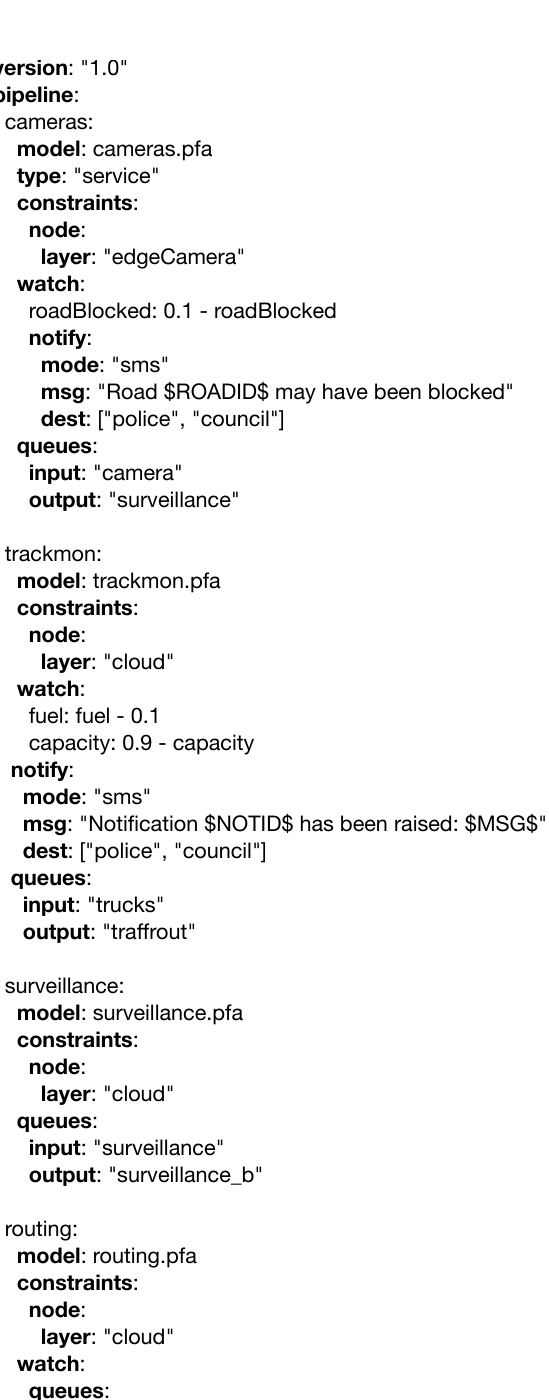
Figure 25. PADL document for the waste management use